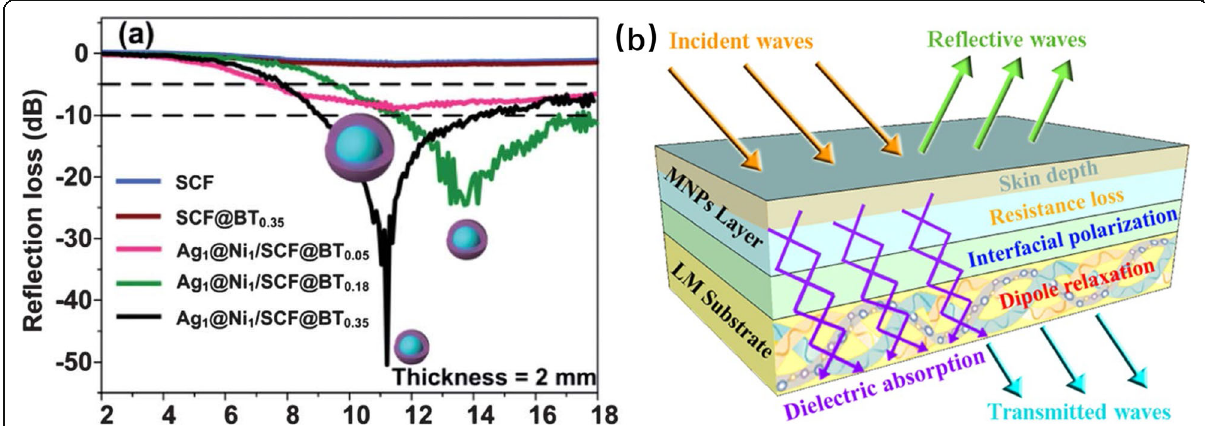
Fig. 5 a Microwave reflection losses of SCF loaded with Ag@Ni core – shell NPs [62]; b Schematic mechanism of high-performance electromagnetic waves shielding leather [77], Copyright (2018), with permission from ACS